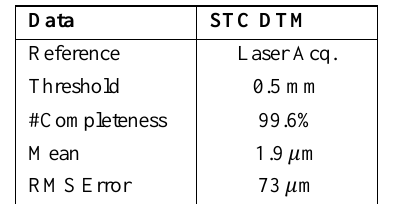
Table 2 Reconstruction performance of the SW in STC Images.